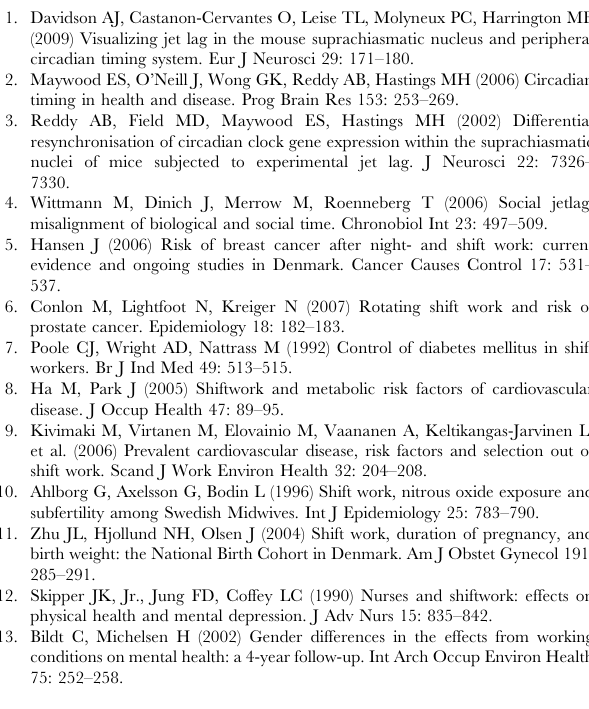
Figure S2 Hypothetical Procedural Time Course. Hypo- thetical activity records and procedural timelines for a control animal exhibiting , 24-hr rhythms in activity (black bars) that were confined to the dark phase (grey bars) of the light:dark cycle and a jet-lagged hamster exhibiting , 24-hr rhythm in behavior. For both control and jet lag animals, all CPP pretest, training and probe trials occurred 4 hrs prior to lights off (yellow bars; ZT10- 14;T1 = training day 1). BrdU injections (red X) occurred the day after every other phase advance at ZT7 for all animals, with perfusions (green X) occurring 24 hrs after the final injection. Cortisol samples were acquired on Days 2, 8, 15, and 25 of the jet lag paradigm (blue arrow). For all animals, blood samples were collected at CT7 based on the individual animal’s activity profile.